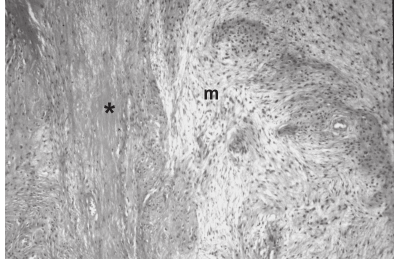
Figure 2b – Microscopic features. Alternating areas of fibrous (asterisk) and myxoid (m) stroma in a whorled growth pattern (hematoxylin and eosin, 63X). These findings associated with diffuse staining for vimentin (not shown) characterize low-grade fibromyxoid